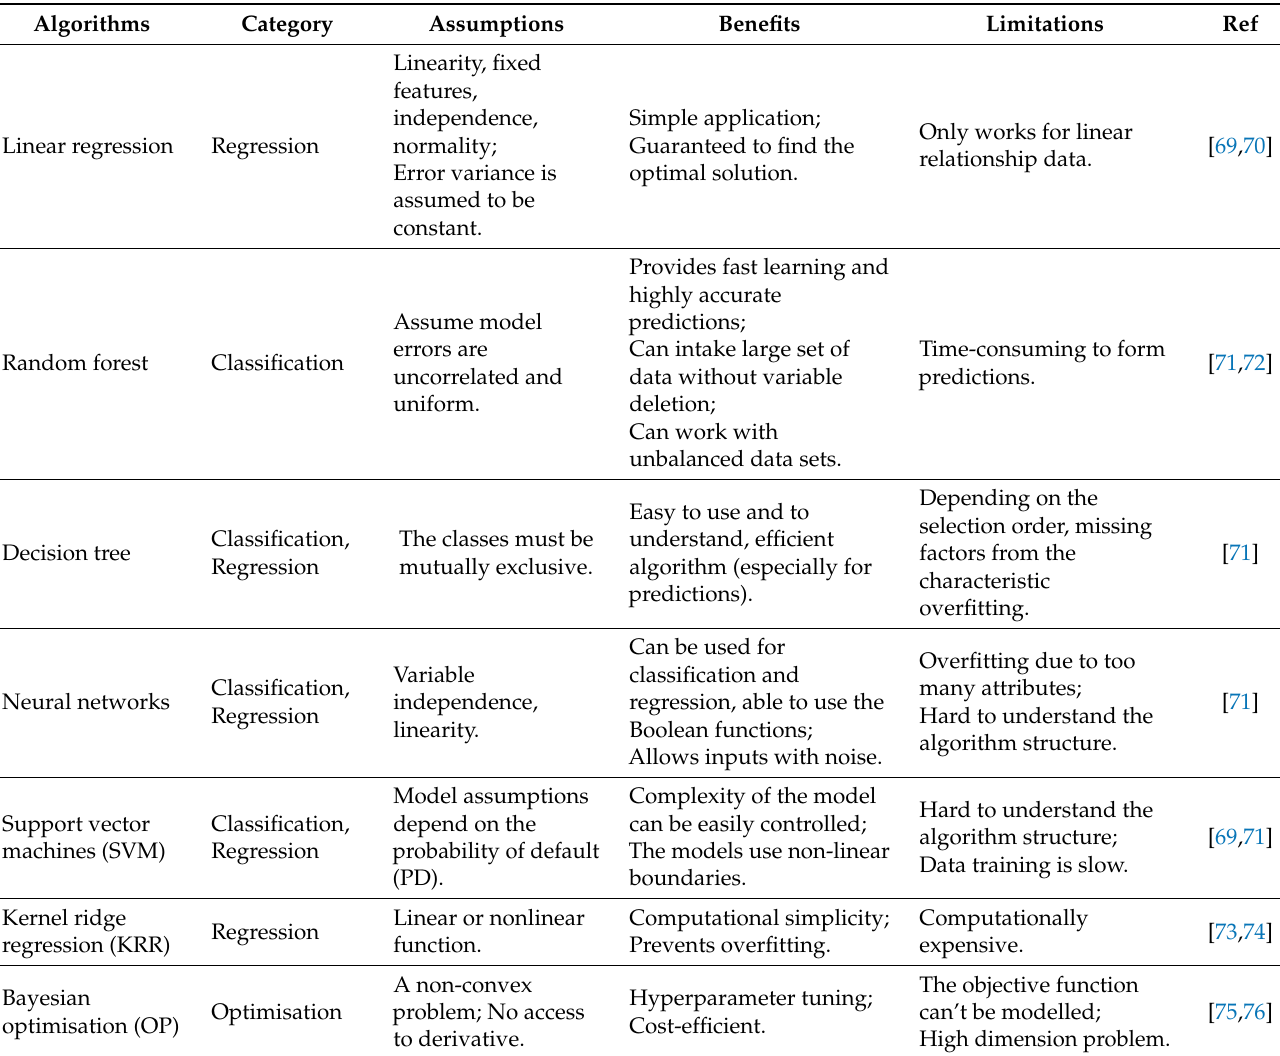
Table 2. ML approaches that can be used in Biomaterials and TE applications.